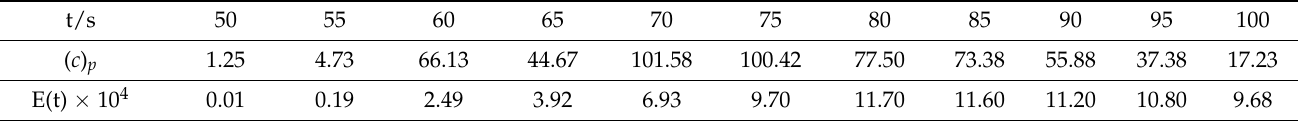
Table 4. The change value of tracer concentration with time and residence time distribution density.